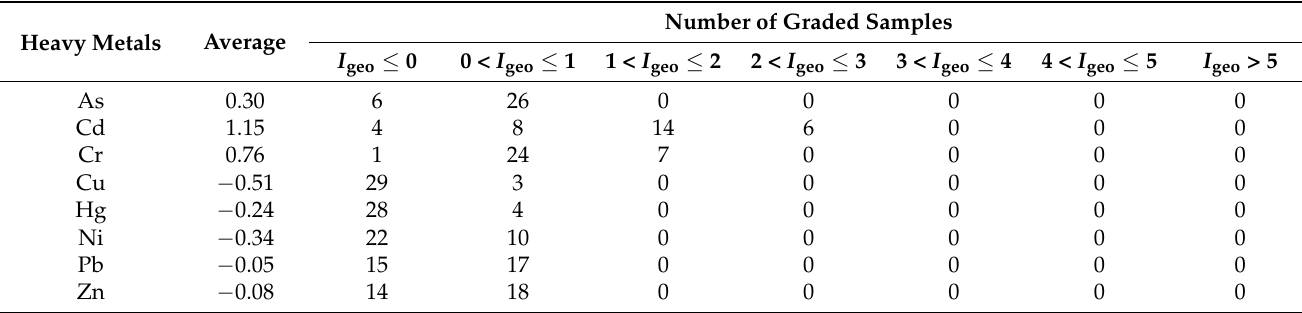
Table 5. I geo classification statistics for heavy metals in surface soil of karst area.